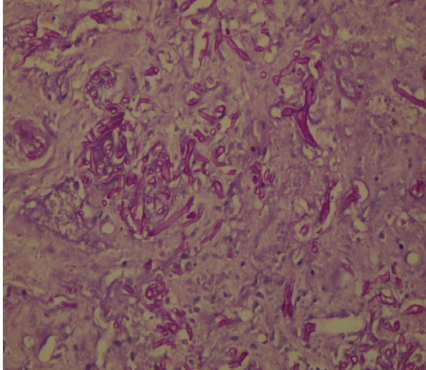
Figure 4: PAS stain confirming colonies of mucormycosis.